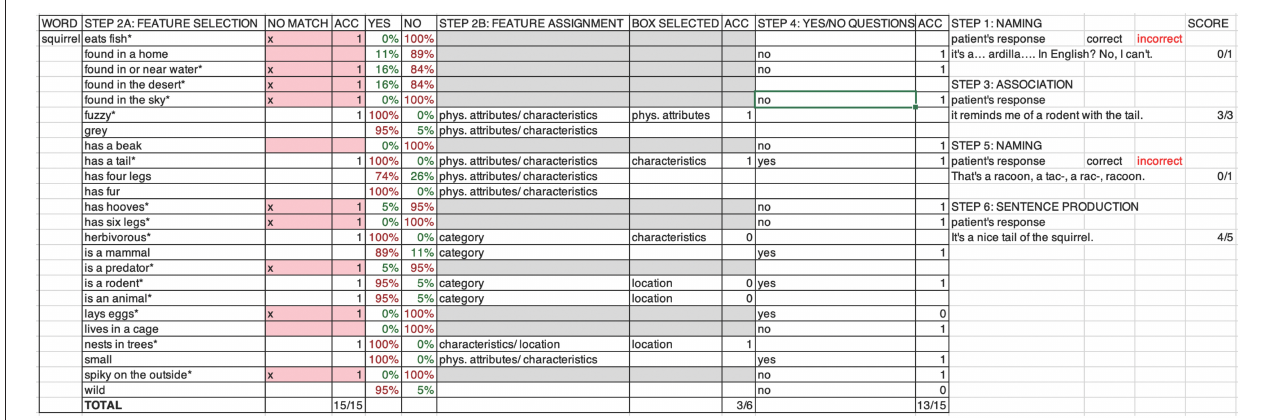
FIGURE 2 | Treatment key. Example of a treatment key displaying the treatment word “squirrel” (column 1). The key helps clinicians to document and score patient responses and provide feedback across treatment steps. The 15 out of 24 semantic features randomly presented in a session are marked with an asterisk (column 2). Features that do not apply to the item are color marked according to the percentage of individuals who determined the feature to be applicable or non-applicable during feature validation (columns 5–6). Patient motor responses are collected for treatment steps 2 (columns 3 and 8) and 4 (column 10), and scored for accuracy (ACC; columns 4, 9, and 11) following color-coded indications on whether or not the feature applies to the item (column 3 for step 2A and columns 7–9 for step 4) or the correct response key for feature assignment (column 7). Verbal responses generated during treatment steps 1, 3, 5, and 6 are written down verbatim by the clinician during the session (column